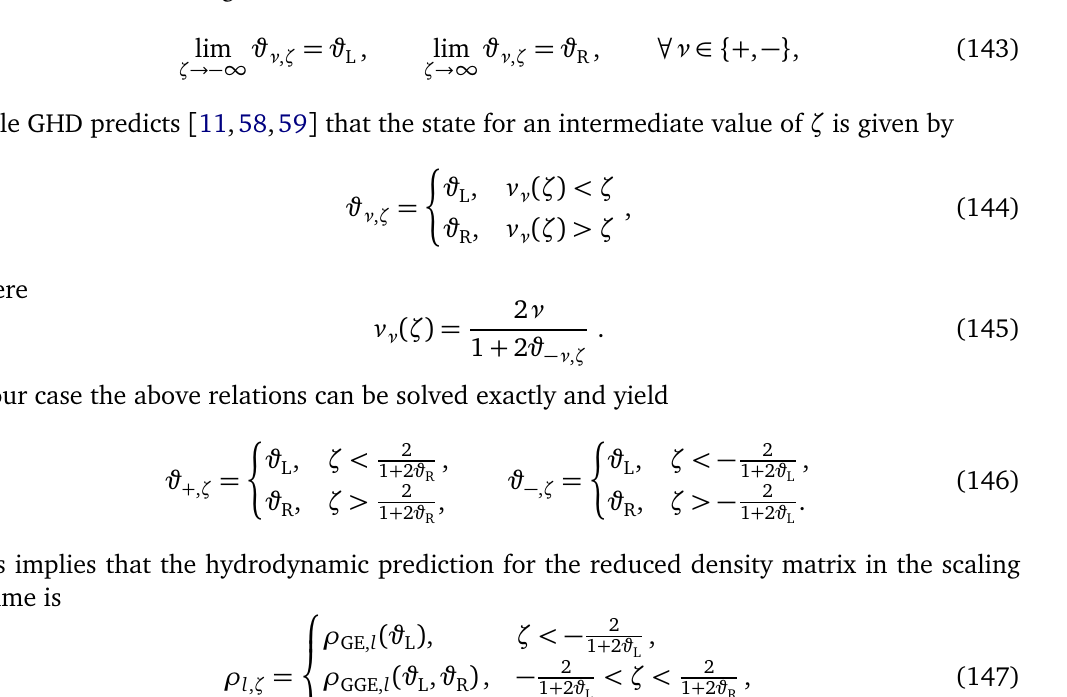
Figure 3: Summary of the results in the scaling limit. For | ζ | > 2 and | ζ | < 2 (rectangles with darker colours) we independently prove the GHD prediction, while < | ζ | < 2 (light rectangles) the microscopic verification is still for 2 3